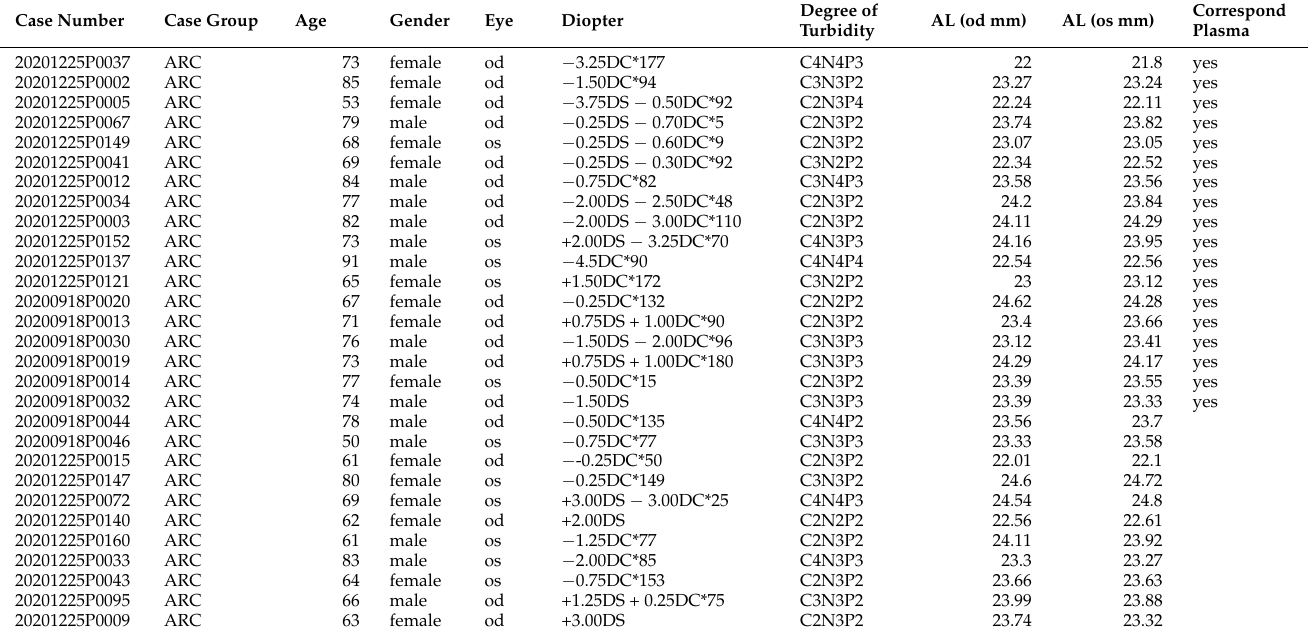
Table 1. Clinical information of